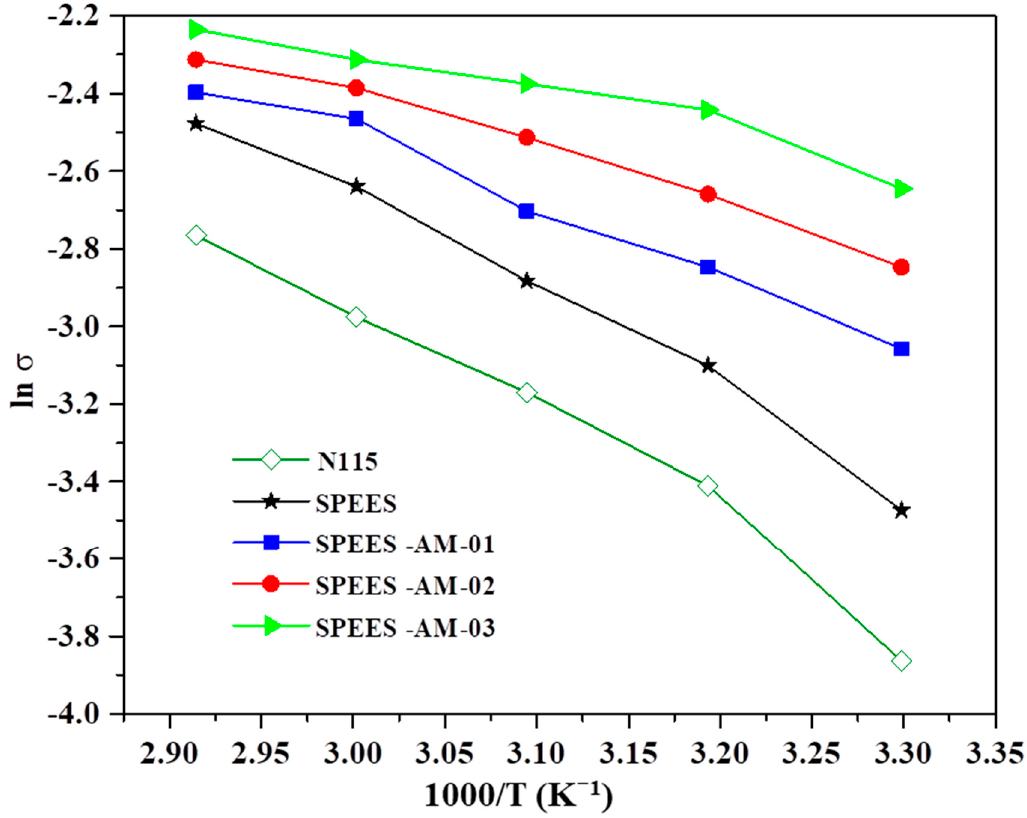
Figure 10. Arrhenius plot of Nafion (N115), SPEES and Figure 10 . Arrhenius plot of Nafion (N115), SPEES and SPEES-AMs.